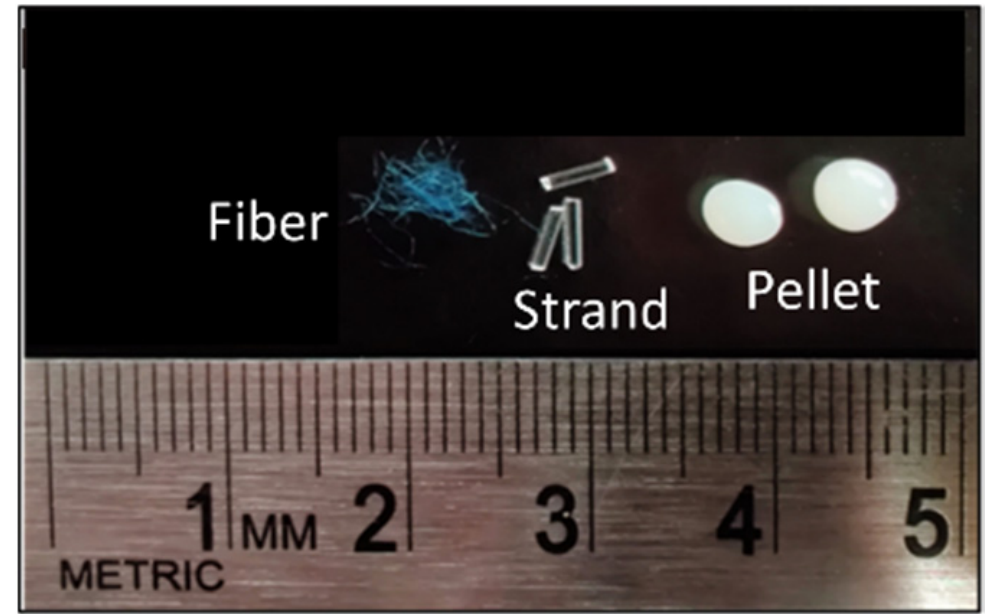
Figure 1. Types of MP used in this experiment.